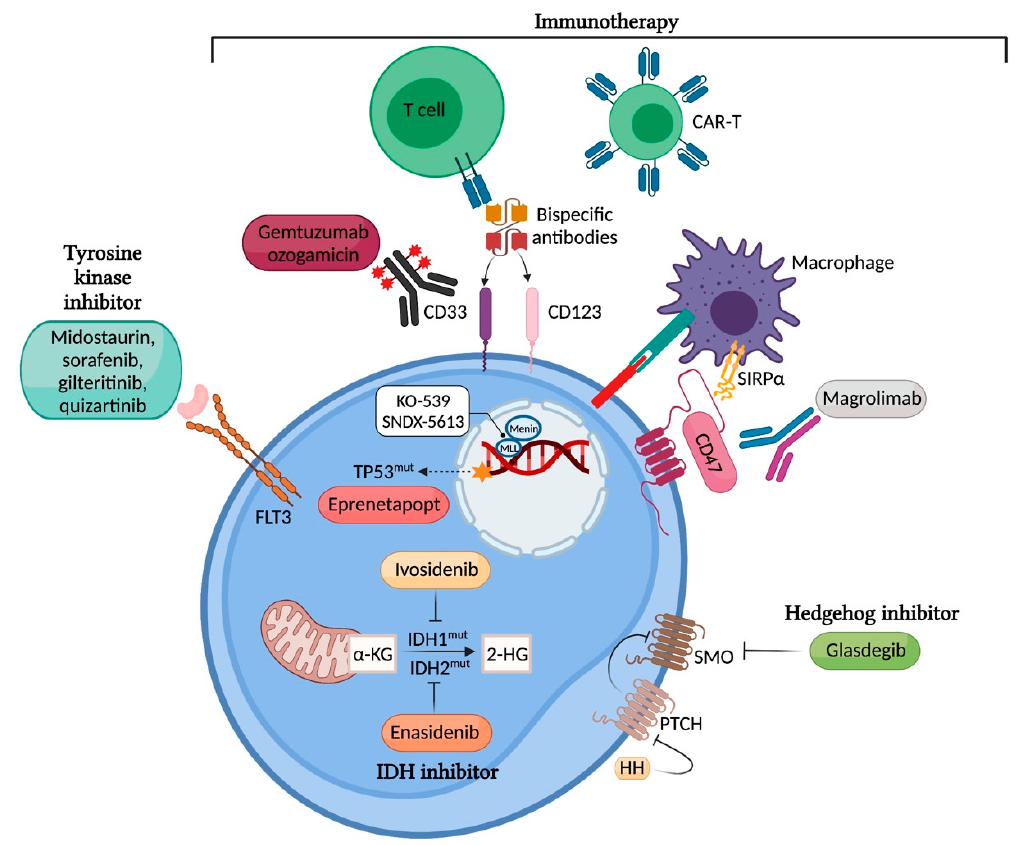
Figure 1. Targeting mutated proteins in AML. Image created with BioRender.com [3] (accessed on 26 September 2021). Targeted therapy with FLT3 inhibitors has significantly improved outcomes in this sub- 47 group. First-generation tyrosine kinase inhibitors (TKIs), such as midostaurin, sorafenib, and lestaurtinib, have demonstrated limited anti-leukemic activity as